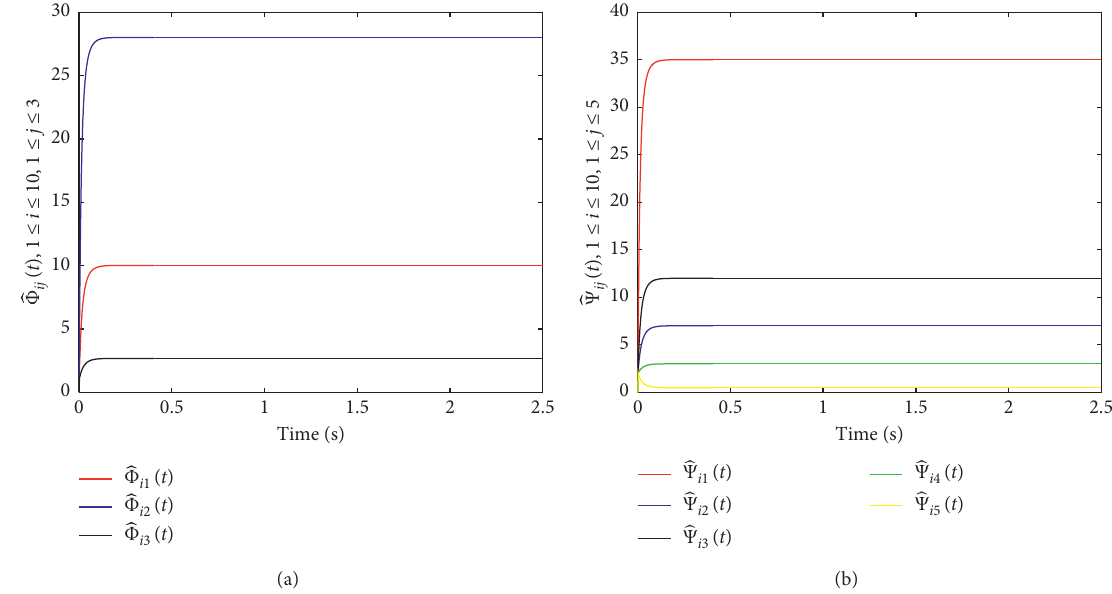
Figure 5: The estimations of unknown parameters for systems (35) and (36) by controller (17). (a) 􏽢 Φ (b) 􏽢 Ψ i ( t )( i � 1 , 2 , ... , 10 ) .